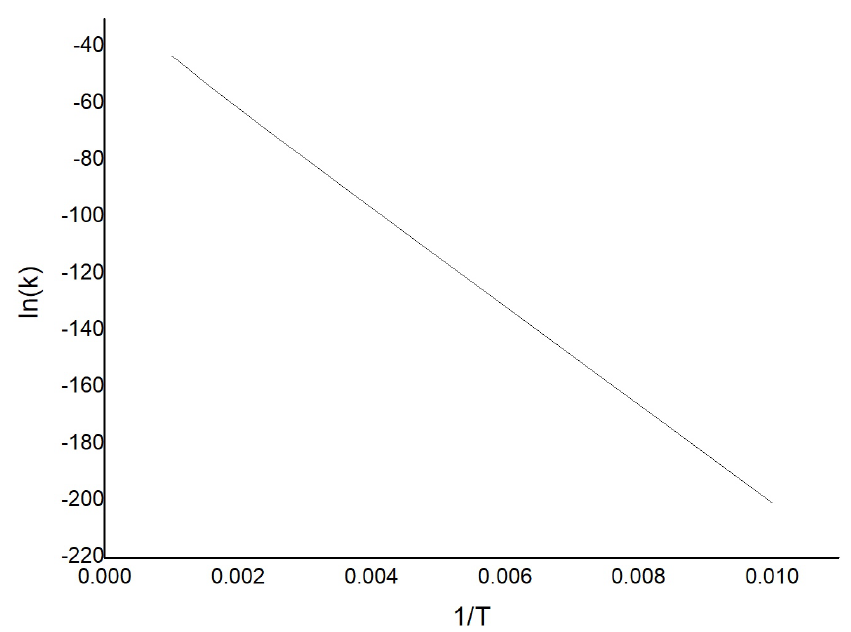
Figure 11. Plot of ln ( k ) vs 1/ T for isomer S1 of the (TiO 2 ) 6